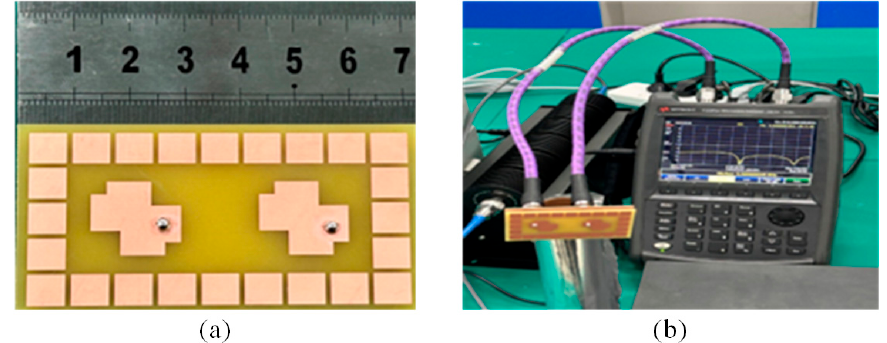
Figure 9. ( a ) Snapshot of the fabricated prototype. ( b ) Photo of measurement setup.